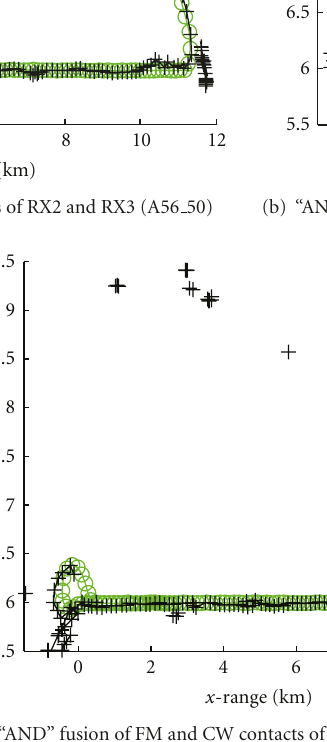
Figure 17: Tracking results for Run A56 50 and A56 TS (target area in